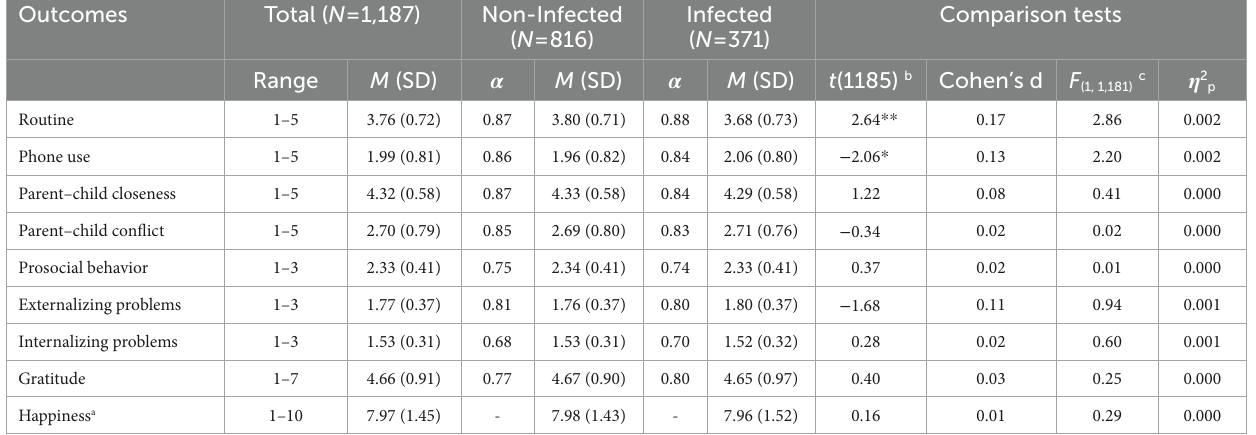
TABLE 1 Descriptive statistics and comparison of main variables between uninfected and infected children.